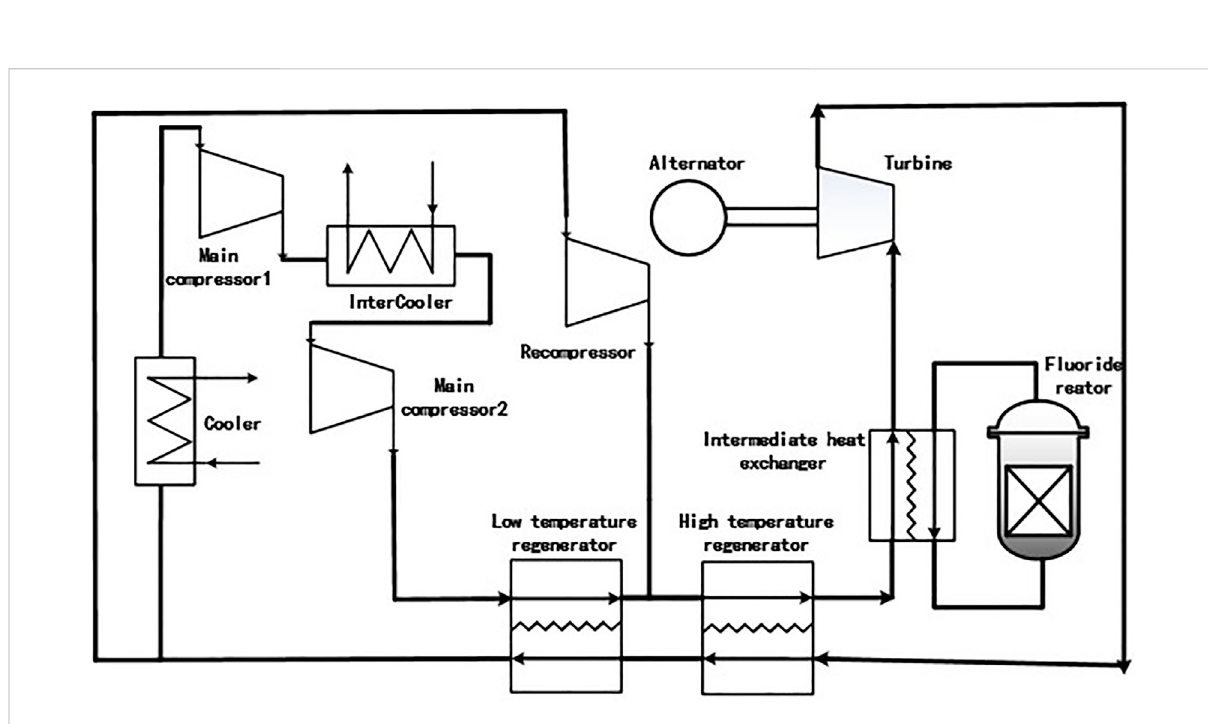
FIGURE 8 Flow chart of the intercooling recompression